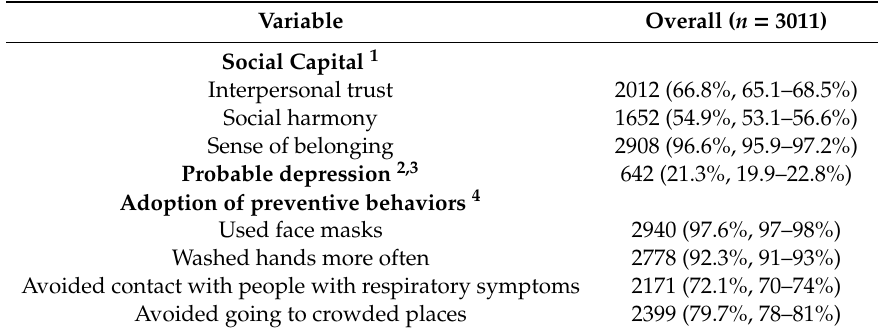
Table 2. Prevalence of probable depression, adoption of preventive behaviors, and social